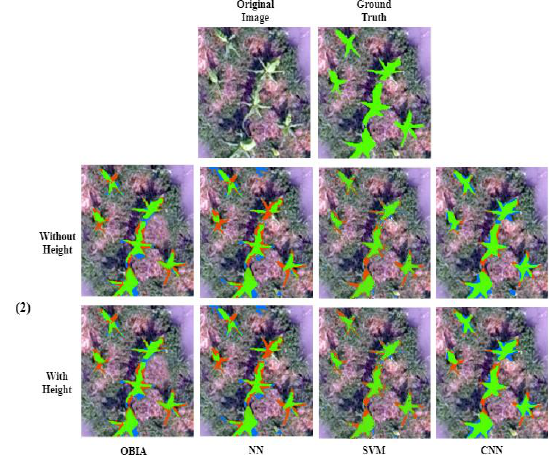
Figure 5. Visualization of prediction of four proposed model for Banana Tree Crown Delineation. Image id (2)